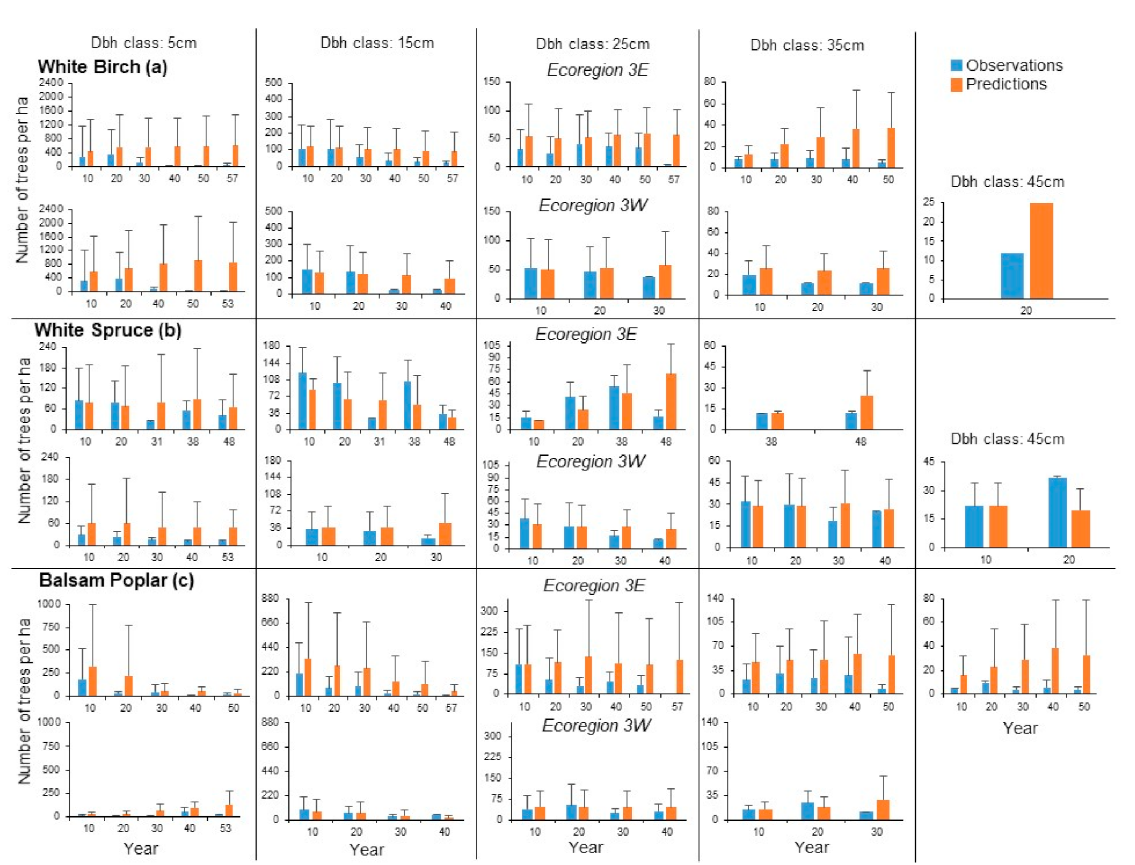
Figure 8. Comparisons between mean observed and predicted stand densities for white birch ( a ), white spruce ( b ) and balsam poplar ( c ) over years in ecoregions 3E and 3W of the boreal forest region of northern Ontario, Canada. Error bars are standard